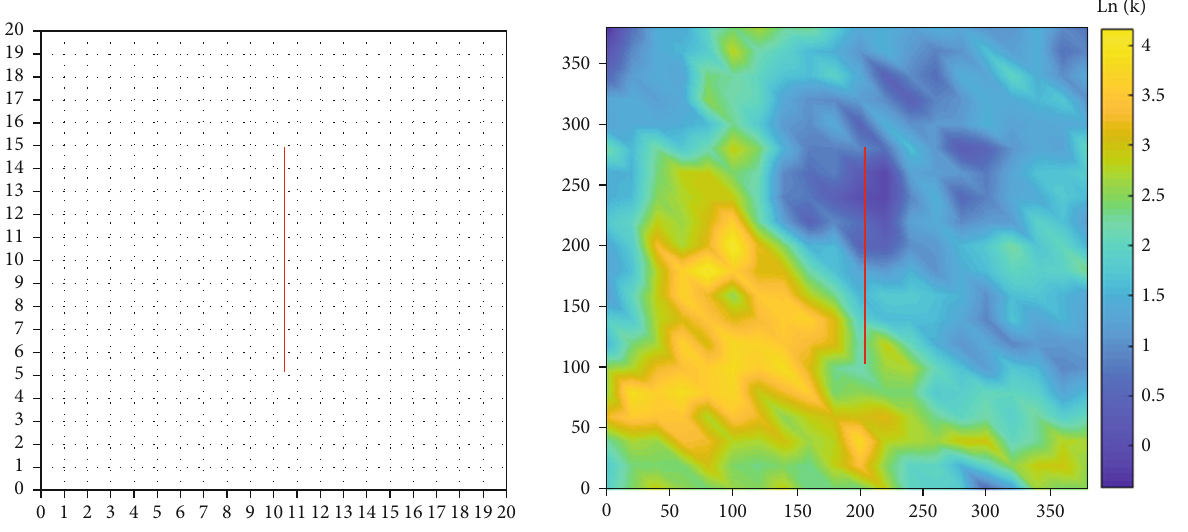
Figure 8: Log-permeability distribution example 2. Table 2: Result of optimal well